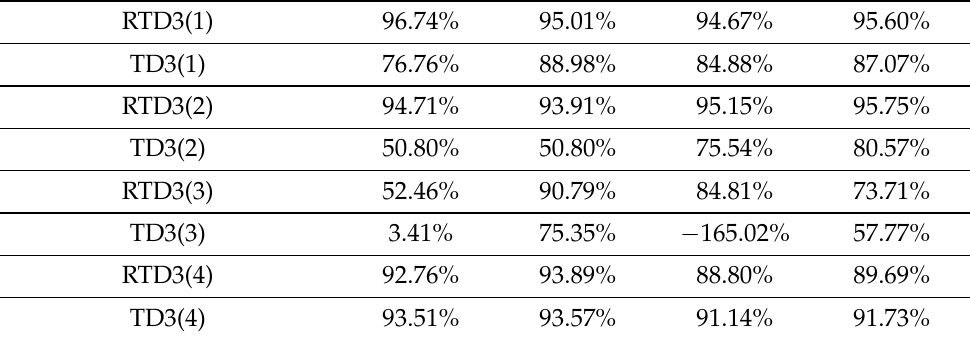
Table 8. Under the four reward function settings, the average efficient distance of RTD3 and TD3 for four times of randomly initialized network node parameters when episode is in the range of 50,000 to